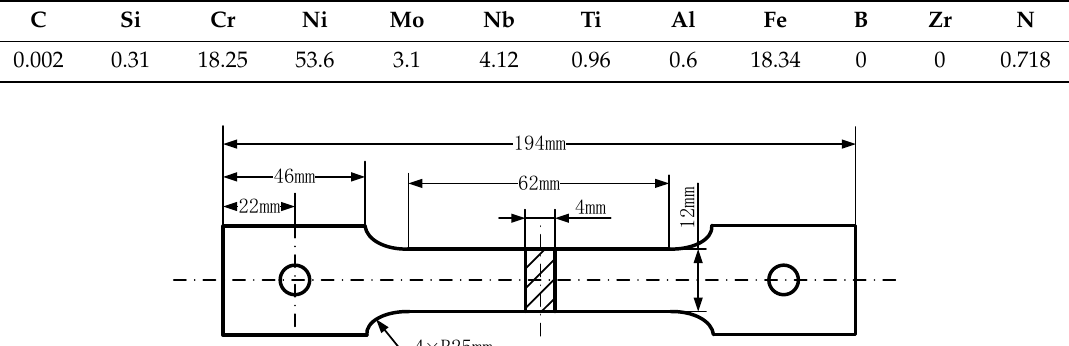
Table 1. Chemical composition (wt.%) of Inconel 718.